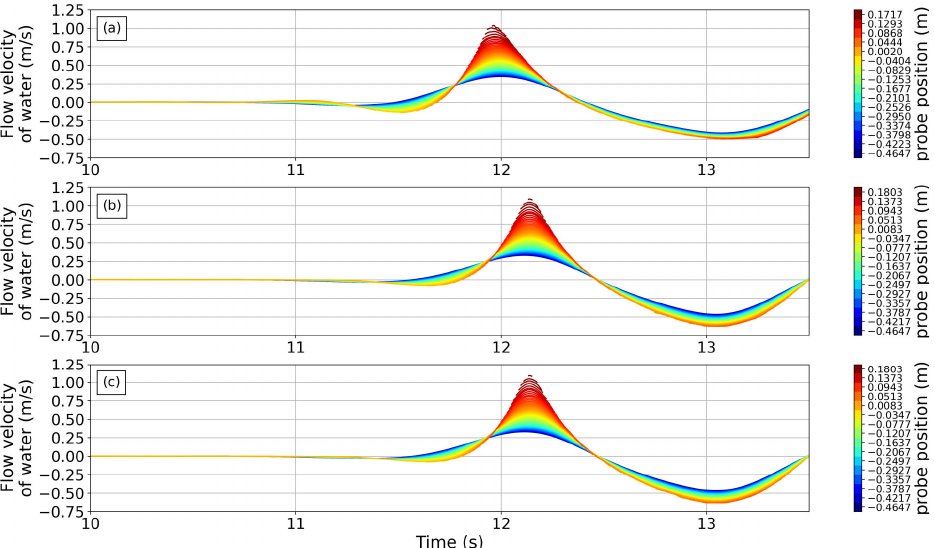
Figure 12. Time histories of flow velocities at probe points in the second scenario at the upstream cylinder ( a ), at the downstream starboard cylinder ( b ), and at the downstream portside cylinder ( c ) for the tripod configuration consisting of large-diameter cylinders. The color bar indicates the vertical position of the probe points.